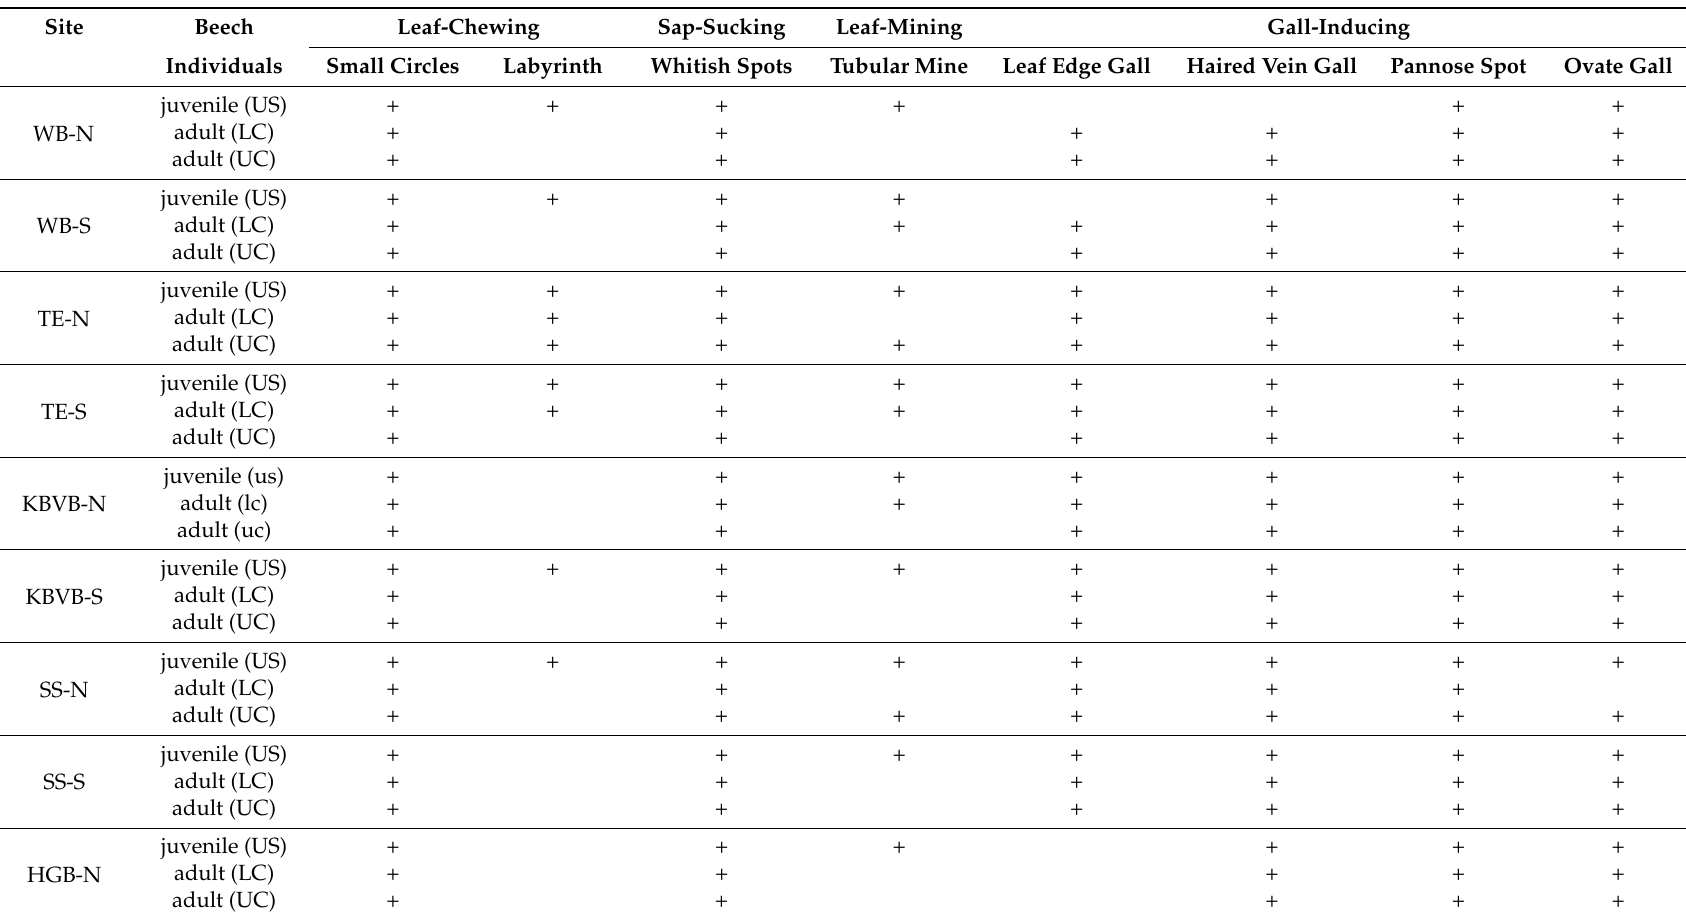
Table A1. Presence (+) and absence of feeding trace morphospecies on leaves of juvenile and adult Fagus sylvatica (European beech) individuals at all sample sites in the understorey and canopies, respectively. Data are based on feeding trace morphospecies identified on collected leaf samples. Site Beech Leaf-Chewing Sap-Sucking Leaf-Mining